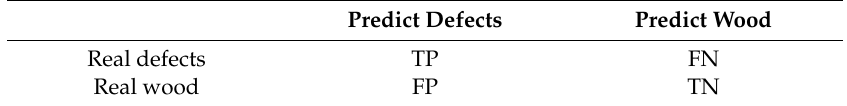
Table 3. Four kinds of classification in confusion matrix. TP indicates the area is correctly predicted as defects. FN indicates the area is incorrectly predicted as normal wood. FP indicates the area is incorrectly predicted defects. TN indicates the area is correctly predicted as normal